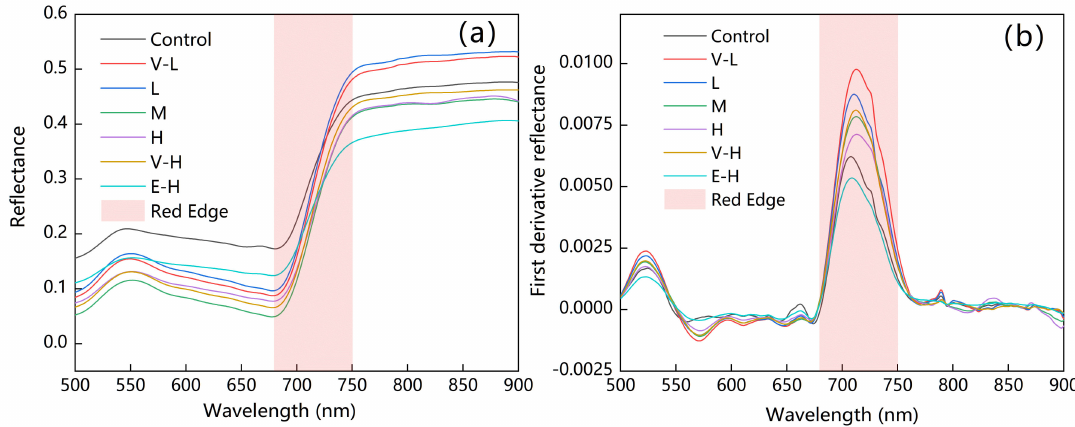
Figure 4. The original spectral curve ( a ) and the first derivative spectral curve ( b ) under di ff erent stresses with di ff erent salt concentrations.